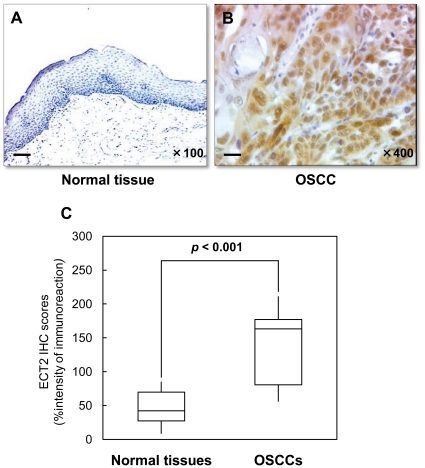
Evaluation of ECT2 protein expression in primary OSCCs.(A, B) Representative IHC results of ECT2 in normal oral tissue and primary OSCC. (A) Normal oral tissue has no ECT2 protein expression. Original magnification, ×100. Scale bars, 50 µm. (B) ECT2-positive cases of OSCC. Positive immunoreaction for ECT2 is detected in the nucleus and cytoplasm. Original magnification, ×400. Scale bars, 10 µm. (C) State of ECT2 protein expression in nomal oral tissue and primary OSCC. To investigate protein expression of ECT2 in primary OSCCs, we carried out IHC. The ECT2 IHC scores are calculated as follows: IHC score = 1×(number of weak stained cells in the field)+2×(number of moderately stained cells in the field)+3×(number of intensely stained cells in the field). The ECT2 IHC scores for OSCCs and normal oral tissues range from 55.67 to 211.33 (median, 163.33) and 8.33 to 85.33 (median, 44.00), respectively. The ECT2 protein expression level in OSCCs is significantly higher than that in normal oral tissues (p<0.001; Mann-Whitney U test).